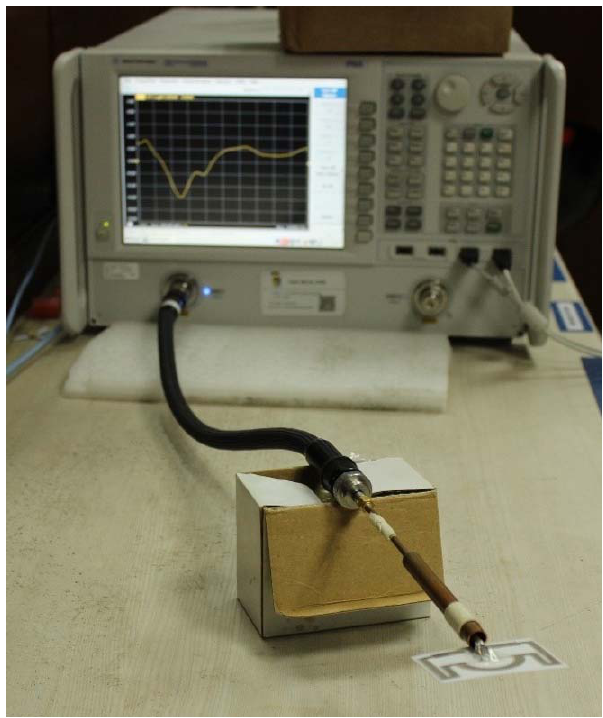
Figure 2. Reflection coefficient measurement of the fabricated prototype.